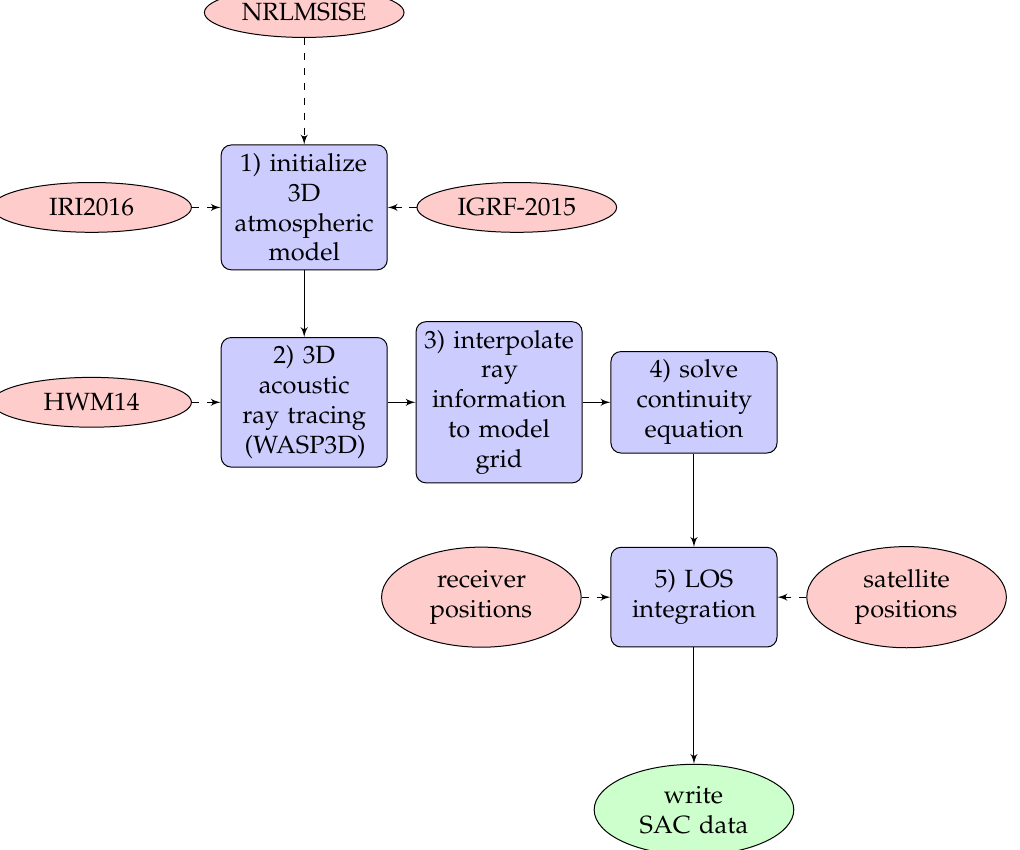
Figure 1. Flow diagram for the IonoSeis modeling framework. The SAC data format is used to store the sTEC time series. NetCDF files are used to store grid information between each step (blue blocks). Red ovals indicate model inputs, and blue boxes indicate individual steps that each have their own BASH script with input parameters for that